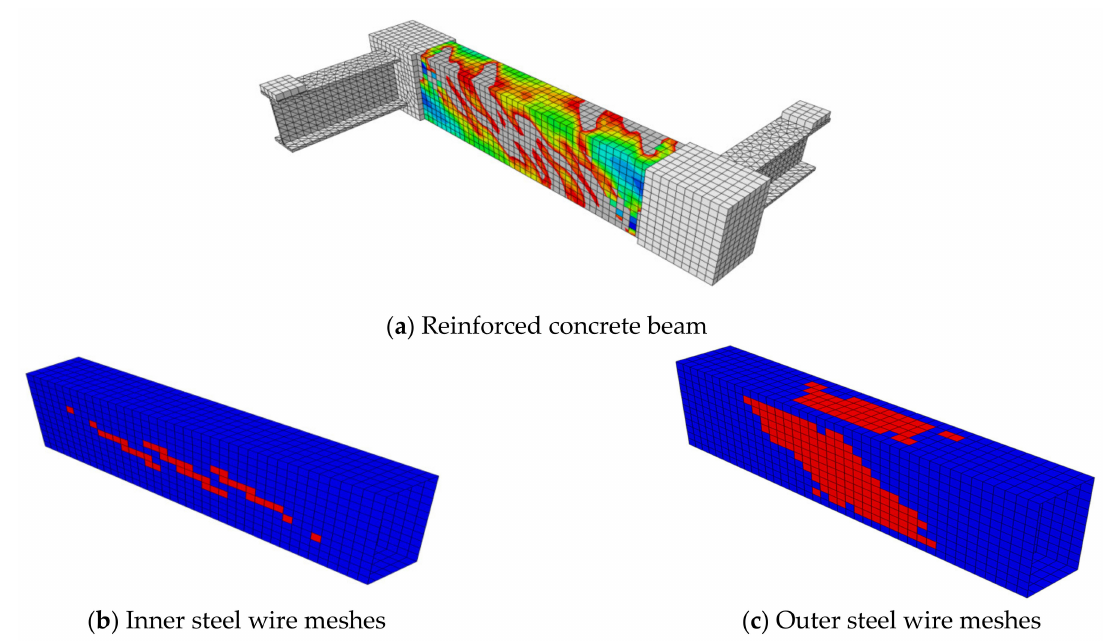
Figure 34. FE final cracks of beam B5-2SM at the ultimate torque.